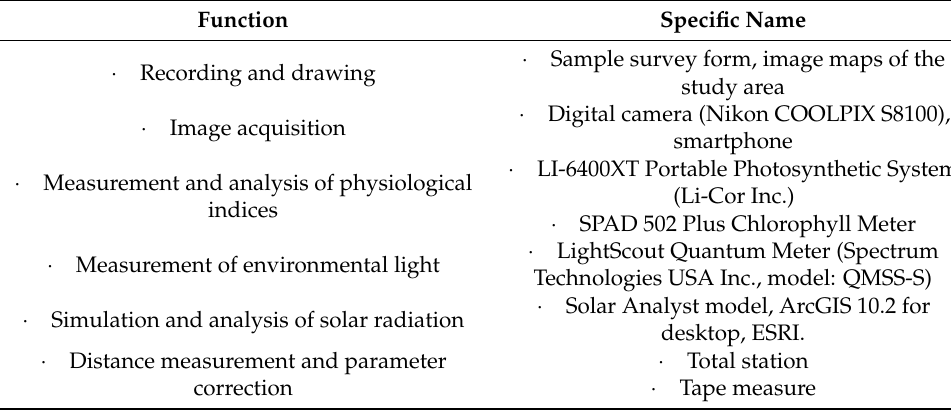
Table 4. Equipment and techniques were used in this